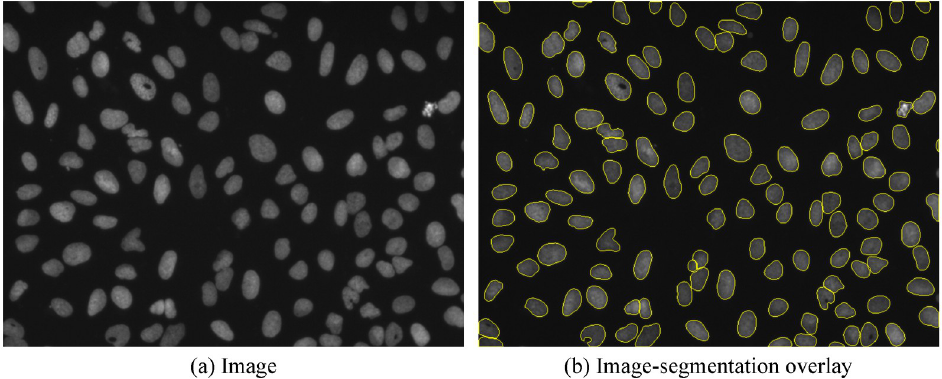
Fig 6. Segmentation of U2OS cells from the BBBC039 dataset [32]. The microbeSEG segmentation model (default settings) has been trained on HeLa cells from the Cell Tracking Challenge [33, 34].